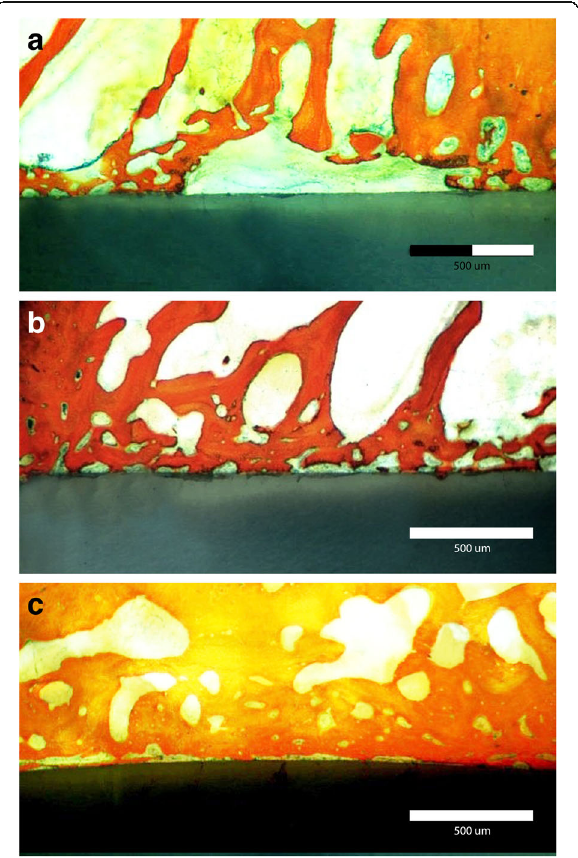
Fig. 3 a Stained histomorphometric section demonstrating bone implant contact of uncoated zirconia implant. b